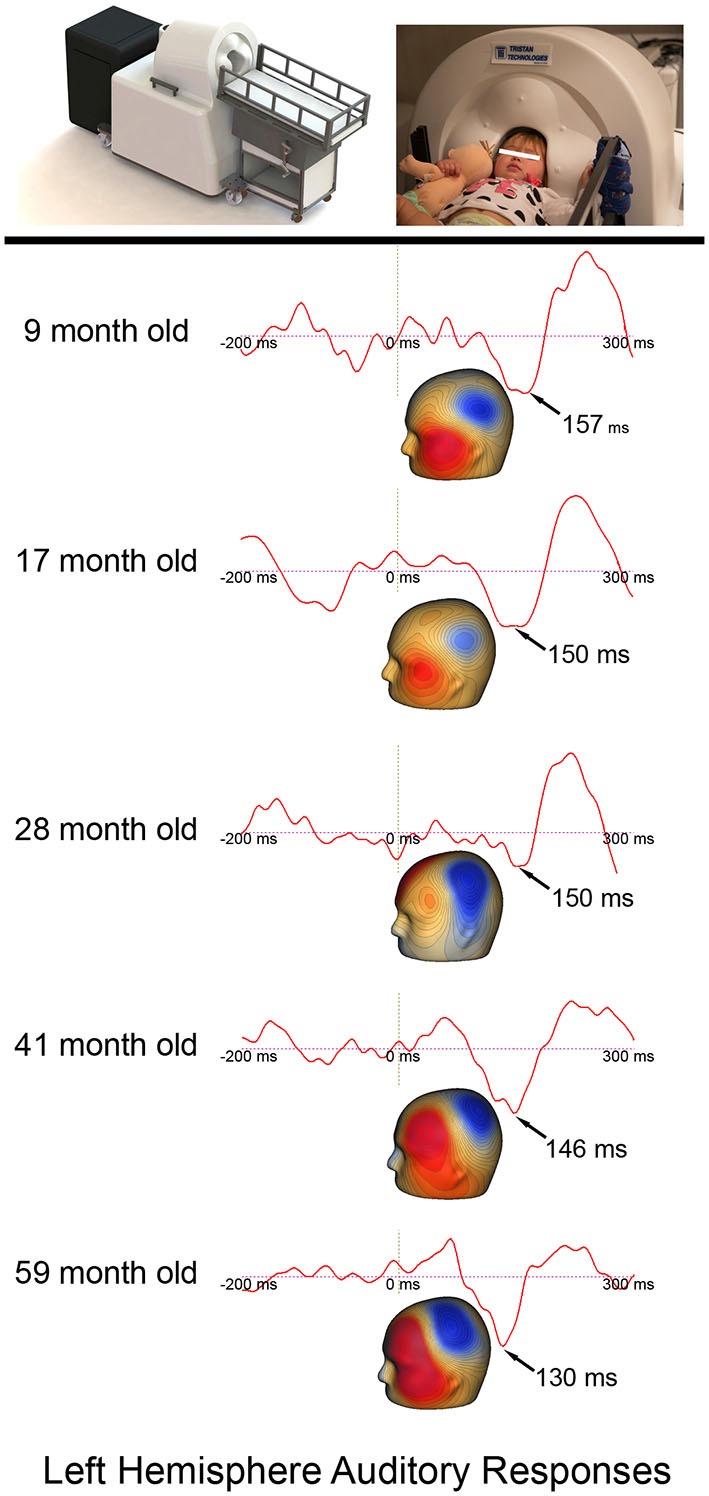
The Artemis 123 system and a child placed in the helmet, along with left hemisphere auditory responses from five participants ranging in age from 6- to 59-months-old. The expected earlier P2m (magnetic field topography shown) auditory latencies in older (~130 ms) vs. younger children (~157 ms) is observed. Permission was granted by the family to publish the participant’s photograph in the top panel.